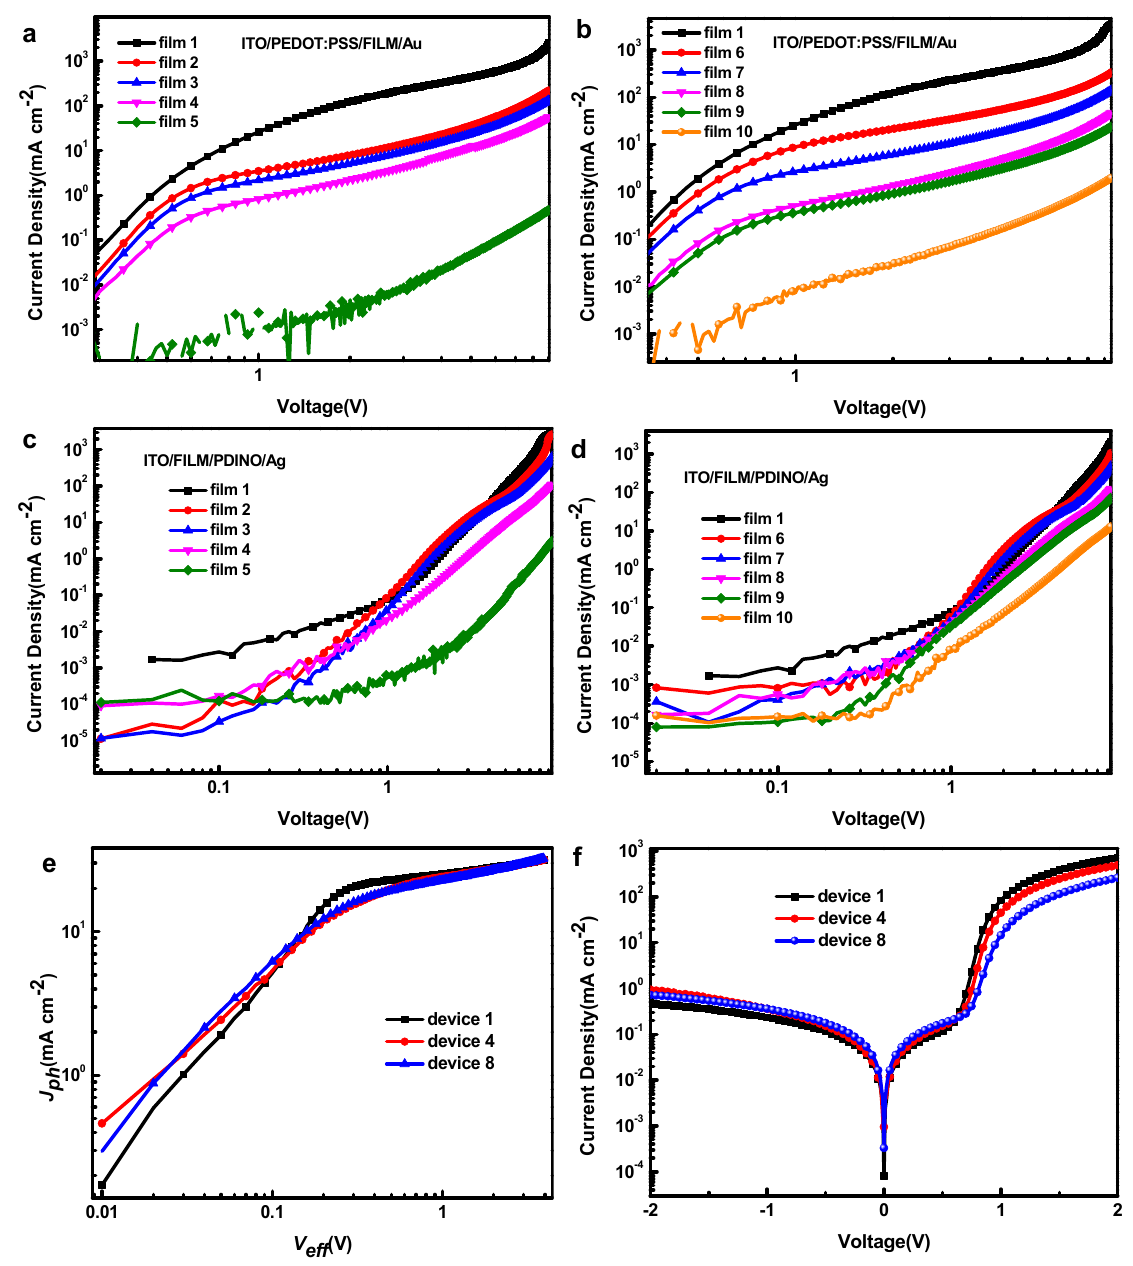
Figure 7. Dark J - V characteristics of hoe-only devices ( a ) 1 to 5, ( b ) 1, 6 to 10. Dark J - V characteristics of electron-only devices ( c ) 1 to 5, ( d ) 1, 6 to 10, ( e ) photocurrent density ( J ph ) versus effective voltage ( V eff ) for devices 1, 4 and 8, ( f ) dark J-V curves of devices 1, 4 and 8.